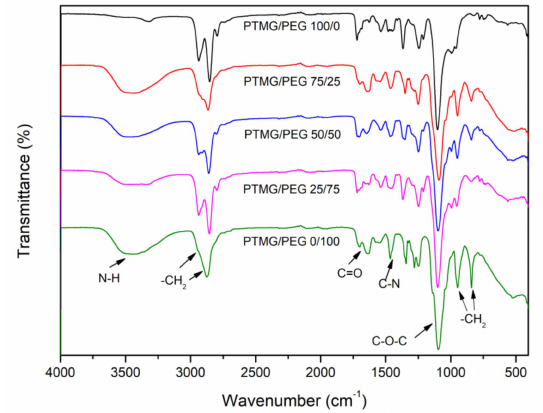
Figure 2. FTIR spectra of PTMG / PEG porous sca ff old